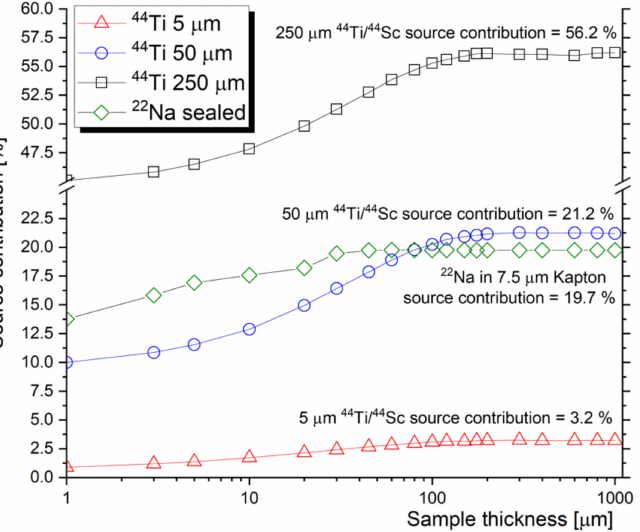
Figure 1. GEANT4 simulation of the source contribution for 44 Ti/ 44 Sc (different thickness of the source foil) and 22 Na (encapsulated in 7.5 µ m Kapton